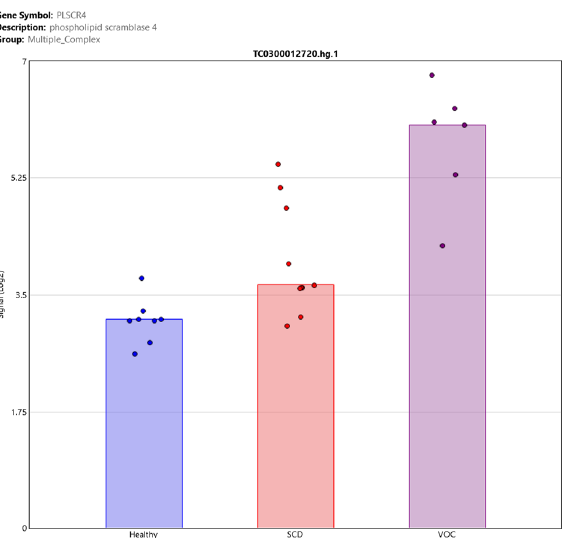
Figure 3. Sample signals of PLSCR4 gene. Sample signals of PLSCR4 gene showing almost 6-folds up-regulation in SCD patients in VOC compared to SCD patients in